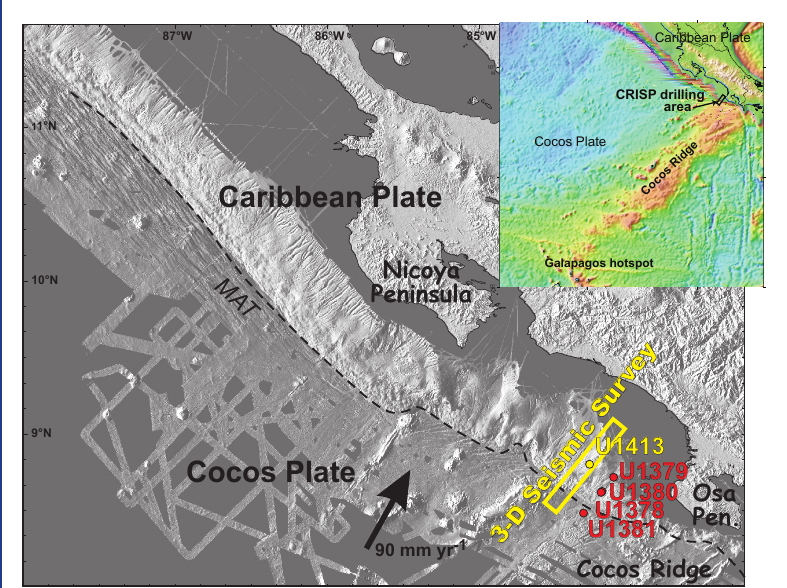
Figure 1. Bathymetric maps of the Cocos Ridge (inset) and of the Costa Rica area, showing the location of the Exp. 334 drilling transect, and the 3-D seismic survey area (Bangs et al., 2011). Seafloor bathymetry is based on swath mapping (Ranero et al., 2008). Note collision of the Cocos Ridge with the trench offshore the Osa Peninsula, which brings the trench very close to the Osa Peninsula coastline and the seismogenic zone within reach of IODP riser drilling capabilities. MAT=Middle America Trench. CRIS 13B is a possible location for deep riser drilling, targeting the seismogenic zone at ~6 km